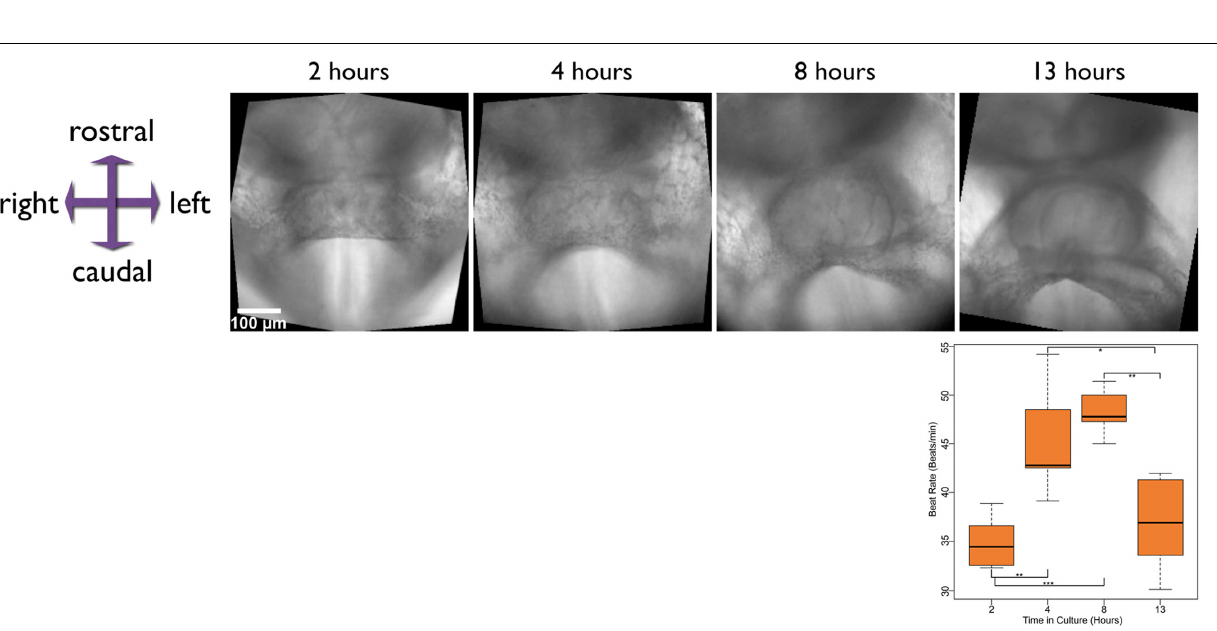
of these stages to capture the contractile activity of the developing heart. The chart plots the beat rate of hearts from five different embryos, at the stages shown. The scale bar represents 100 microns. ∗ ≤ 0 . 05, ∗∗ ≤ 0 . 01, and ∗∗∗ ≤ 0 . 001. Also see Supplementary Movie 2